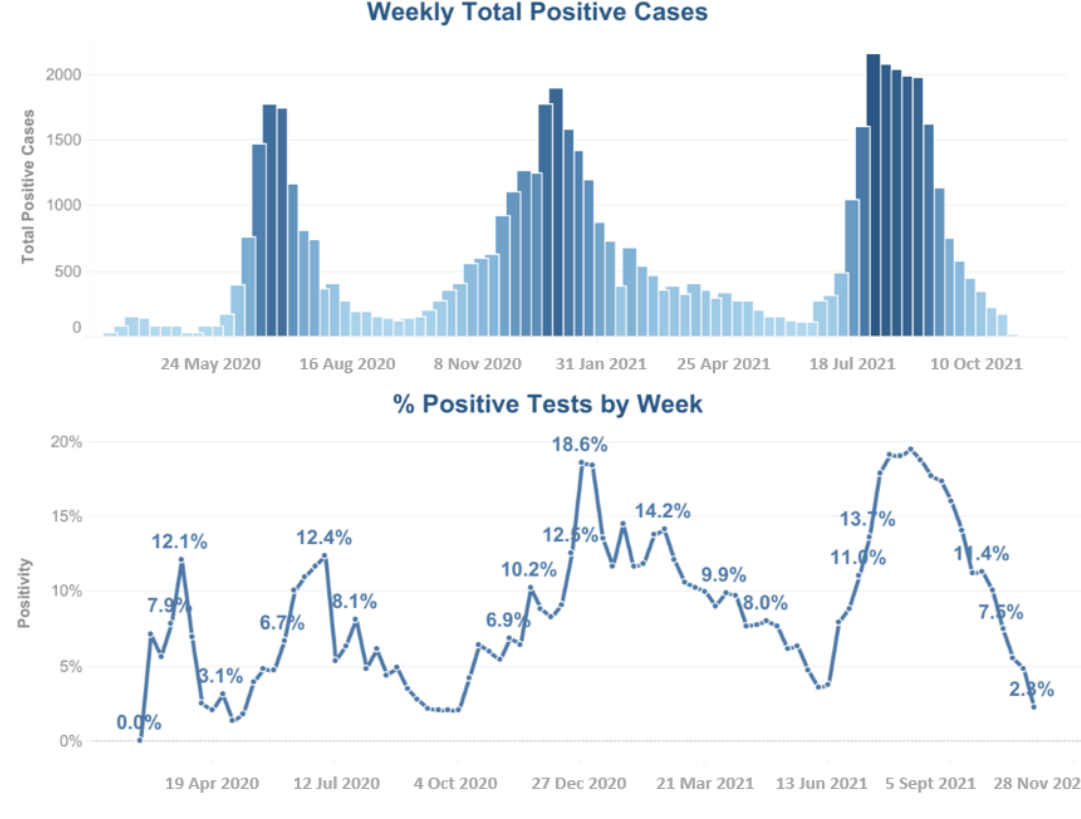
Figure 5. (Galveston County COVID-19 Weekly Positive Case Trends.) Overall COVID-19 cases in Galveston County from about March 2020 through November